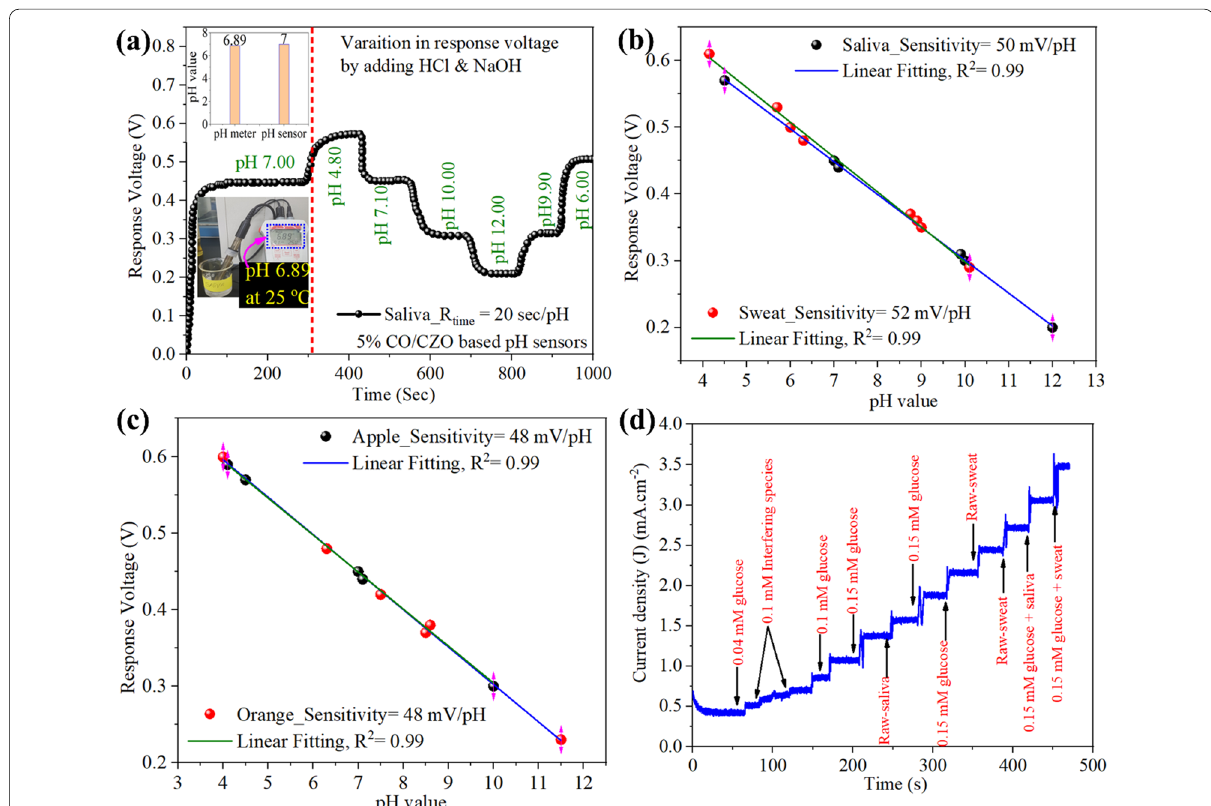
Fig. 8 a Real-time monitoring results of pH in human saliva (insets: (above) bar graph comparing the pH results obtained by pH meter and pH sensor. Sensitivity response of the CO/CZO based device when immersed in b saliva and sweat fluids and c apple and orange and changing their pH with HCl and NaOH. d Amperometric I-t plot of CO/CZO based electrodes towards raw and glucose added human